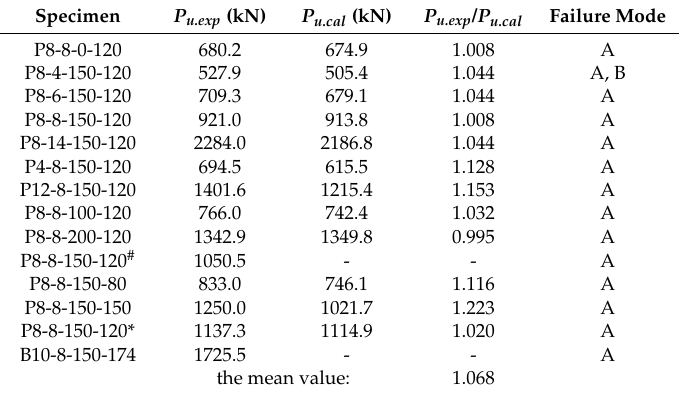
Table 5. Failure mode and comparison of calculated ultimate bearing capacities and test